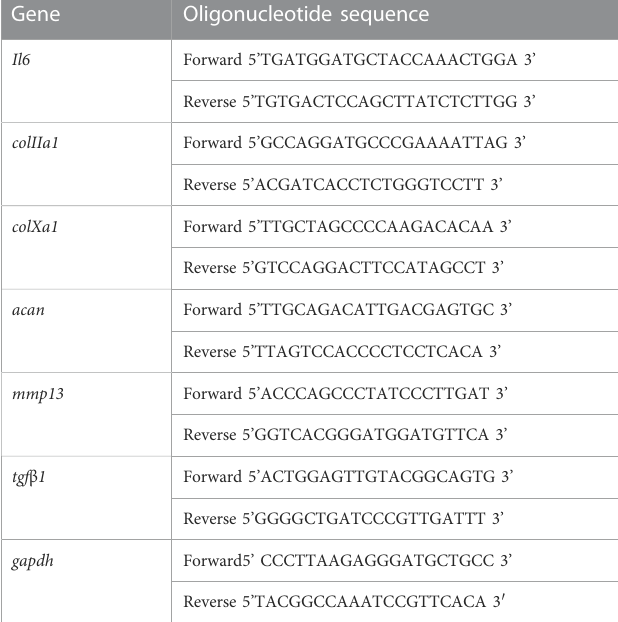
TABLE 2 Primer sequences for